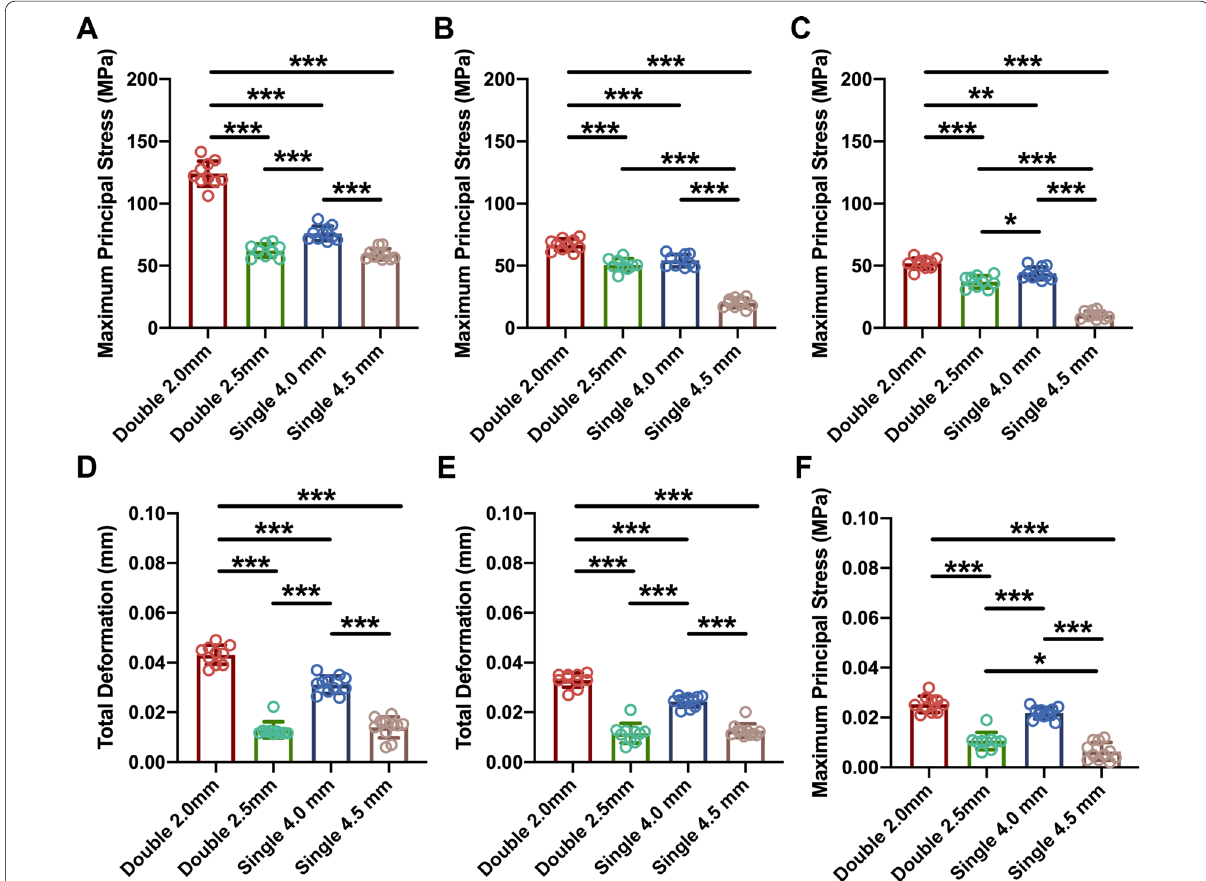
Fig. 6 Comparison of the maximum principal stress and the maximum deformation obtained with different fixation patterns. A , D The maximum principal stress and the maximum deformation were both smallest when using a single 4.5‑mm fixation bolt at 30° flexion. B , E The maximum principal stress and the maximum deformation were both smallest when using a single 4.5‑mm fixation bolt at 90° flexion. C , F The maximum principal stress and the maximum deformation were both smallest when using a single 4.5‑mm fixation bolt at 130° flexion. Data shown are the mean and SD. n 10; * p < 0.05, ** p < 0.01, *** p < =